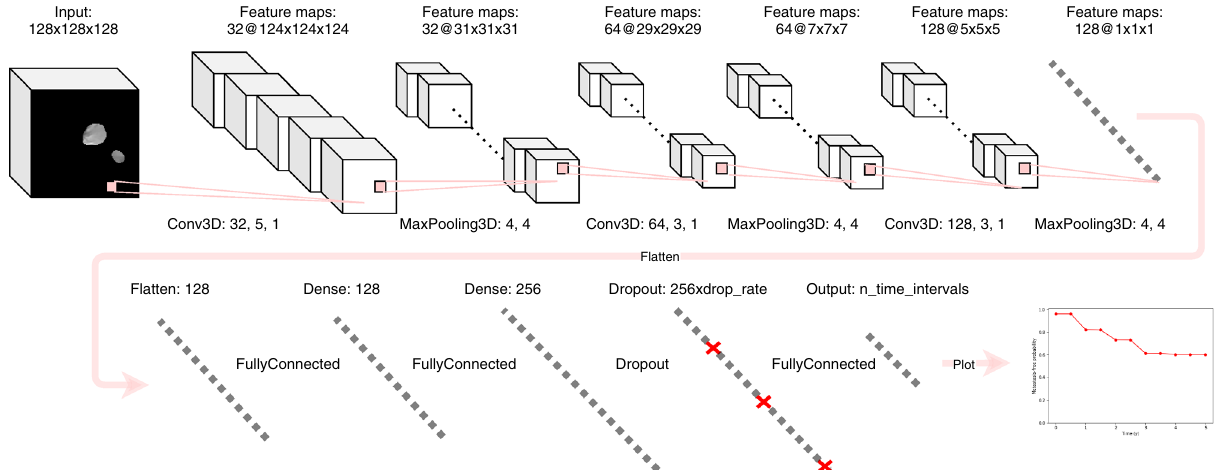
Figure 4. Time-to-event 3D convolutional neural network architecture. The general network architecture is based on the 2D CNN implemented by Diamant et al. 22 plus the discrete time-to-event model by Gensheimer et al. 27 . Numbers for the convolutional layers represent the number of kernels, the kernel size and the stride. Numbers for the max-pooling layers represent the pool size and the